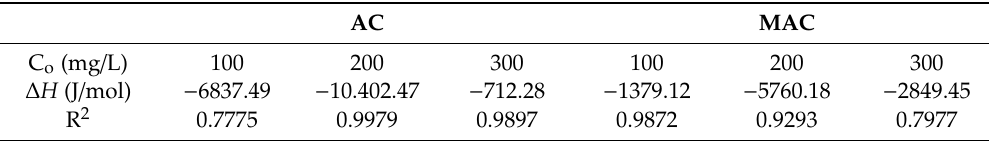
Table 5. Enthalpy change at 100, 200, and 300 ppm for AC and MAC.